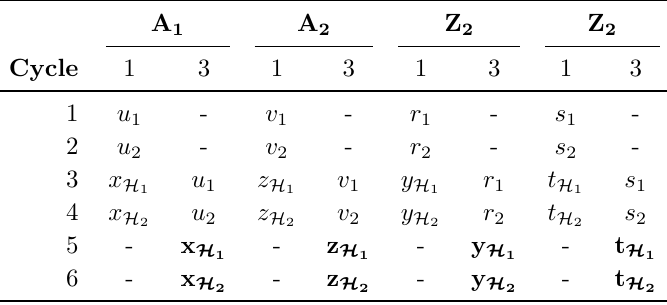
Table 2: Instruction scheduling for two successive Hadarmard computations as in line 8 of Algorithm 4 ( mont _ ladder ) using modular addition ( A ) and subtraction ( Z ).